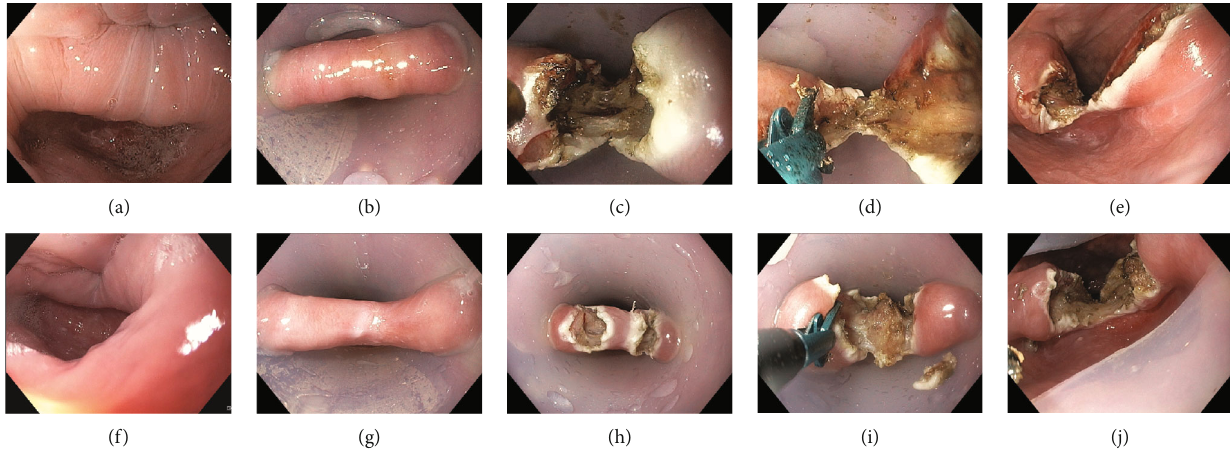
Figure 1: (a) Symptomatic ZD of a 73-year-old male patient. (b) Fixation of the diverticulum with an overtube. (c) Incision of the mucosa and the upper muscular fi bers of the diverticular bridge. (d) Cutting down the diverticular bridge with the sb knife jr. (e) Final result after the fi rst session. (f – j) Second session because of recurrence 16 months